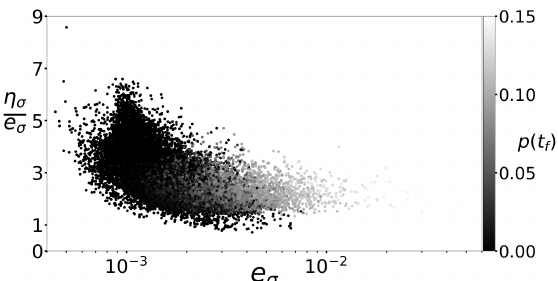
Figure 8. Effectivity of the coherence estimator η σ (17) associated with σ . The color scale indicates the final cumulative